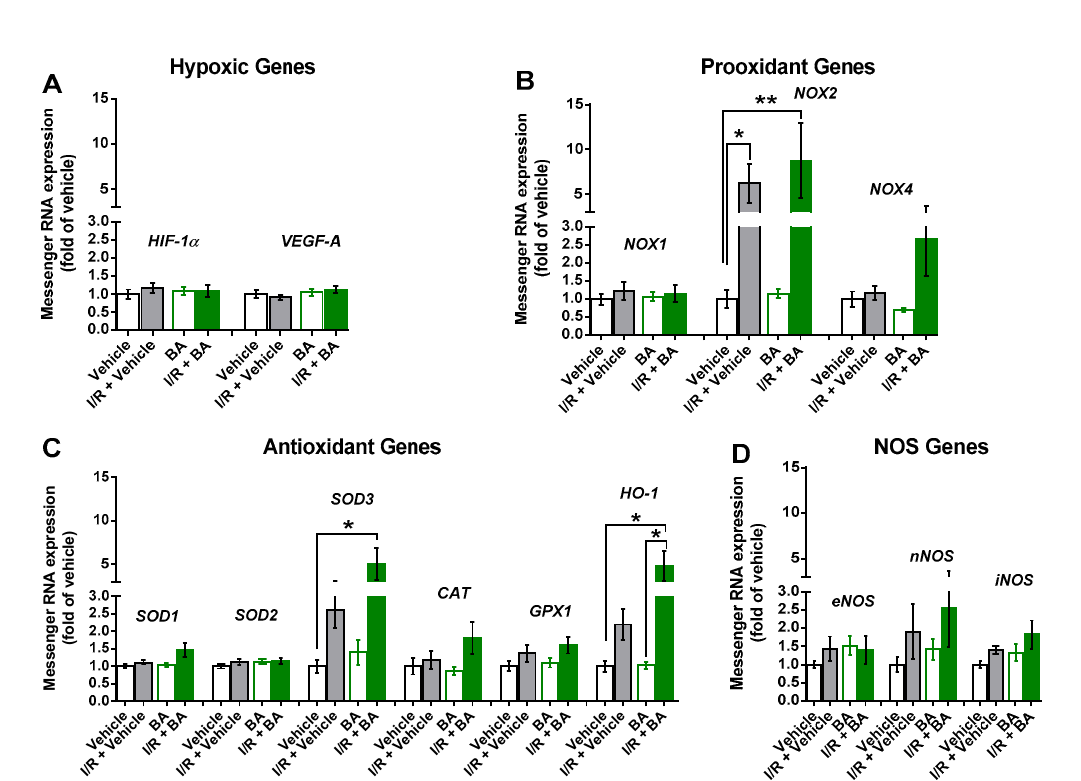
Figure 4. Messenger RNA expression of the hypoxic genes, HIF-1 α and VEGF-A ( A ), the prooxidant genes ( NOX1 , NOX2 , NOX4 ) ( B ), the antioxidant genes ( SOD1 , SOD2 , SOD3 , CAT , GPX1 , HO-1 ) ( C ) and of the NOS genes ( eNOS , nNOS , iNOS ) ( D ) in the eyes treated with vehicle only, I/R + vehicle, betulinic acid (BA) only and I/R + BA. Notably, BA did not prevent upregulation of NOX2 expression induced by I/R. However, mRNA expression of the antioxidant redox genes, SOD3 and HO-1 , was markedly increased in mice exposed to I/R and BA. Data are presented as the mean ± SE (** p < 0.01; * p < 0.05; n = 8 per